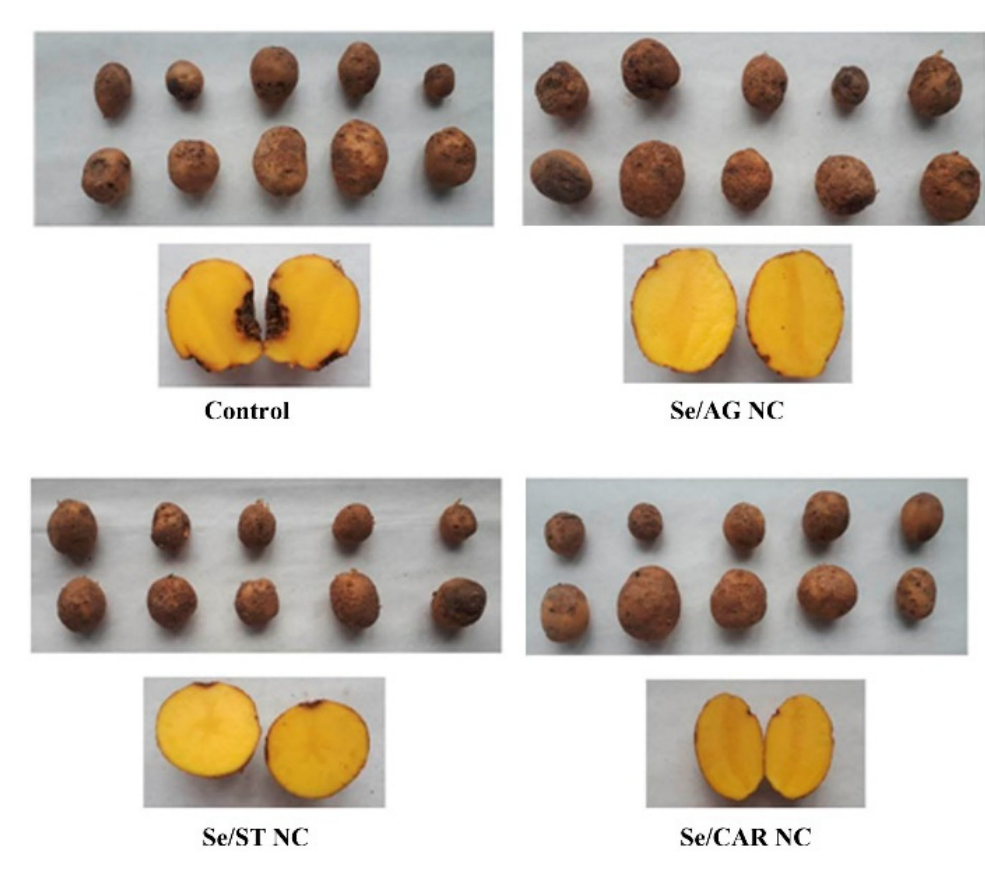
Figure 4. Potato tubers in the first generation obtained from plants grown from tubers treated with selenium (Se) nanocomposites (NCs) and untreated tubers (control) after 230 days of storage. Se/AG NC, Se/ST NC and Se/CAR NC are arabinogalactan-, starch- and kappa-carrageenan-based Se nanocomposites. Table 3. Analysis of tuber traits in the first generation obtained from plants grown from tubers treated with selenium (Se) nanocomposites (NCs) after 230 days of storage.